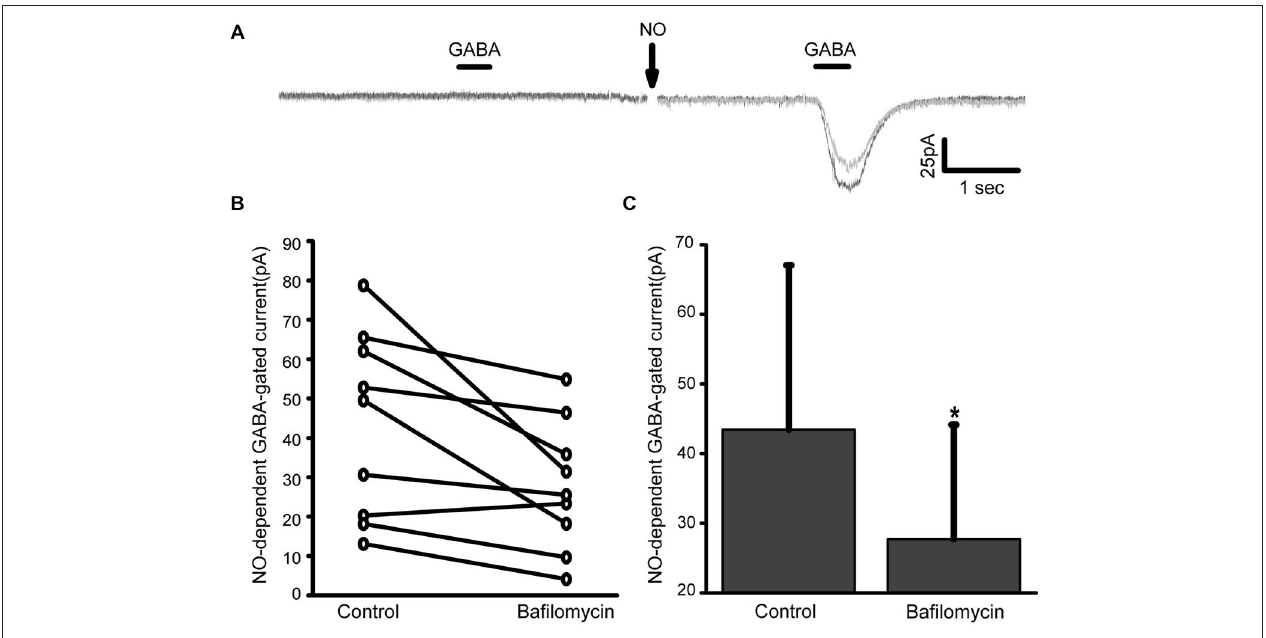
plasma membrane. After bafilomycin (gray trace), the NO-dependent GABA-gated current is smaller indicating a reduction in the release of internal Cl − . (B) , NO-dependent GABA-gated current amplitude is plotted for each cell tested both before and after exposure to bafilomycin. (C) , Mean GABA-gated current amplitude is significantly smaller in bafilomycin. * denotes p <